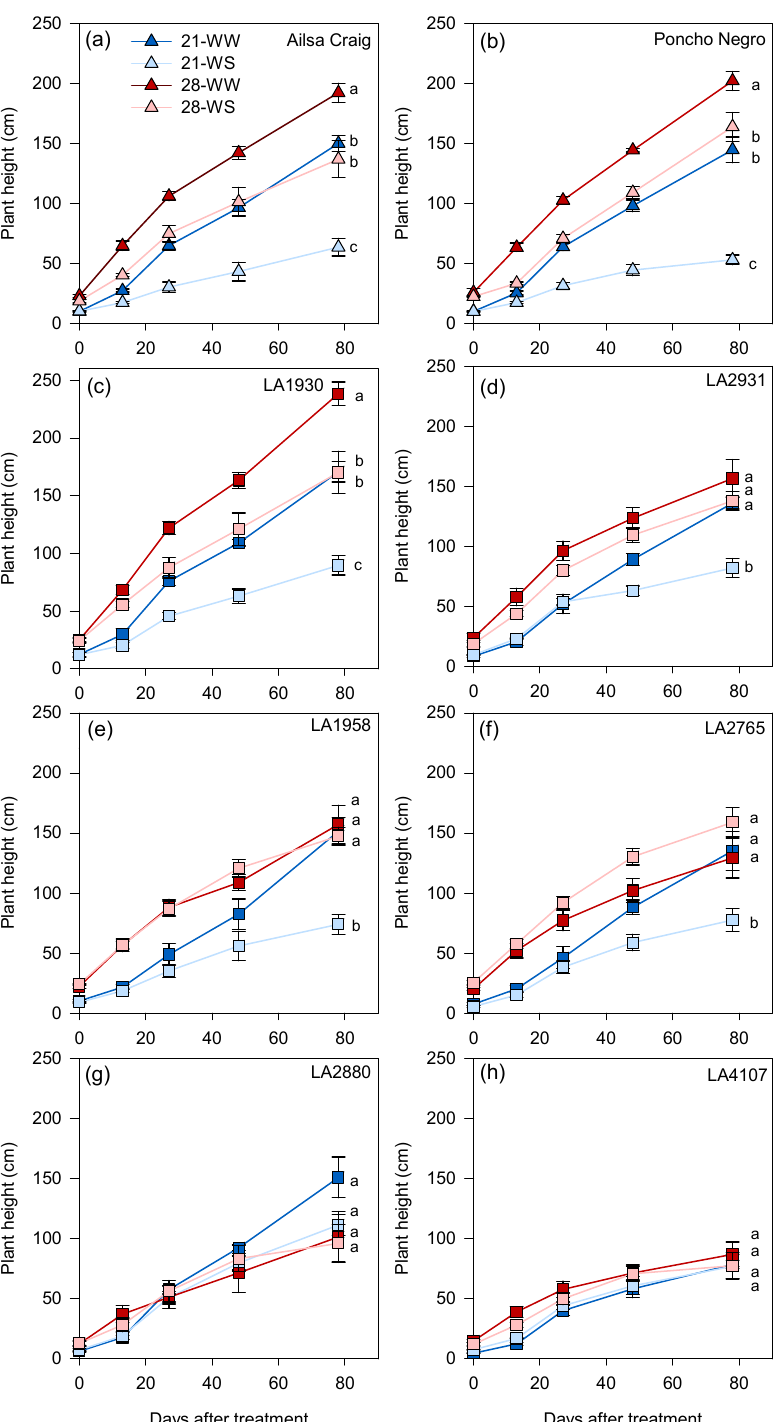
Figure 2. Effect of temperature and water stress on plant height of ( a , b ) S. lycopersicum cultivars and ( c – h ) S. chilense populations. Plants were grown at 21 °C under well-watered (21-WW) and water stress (21-WS) conditions or at 28 °C under well-watered (28-WW) and water-stressed (28-WS) conditions; triangle: S. lycopersicum , square: S. chilense . Treatments followed by different letters are significantly different at p < 0.05 for a same accession at the end of the experiment. Data ± SE.